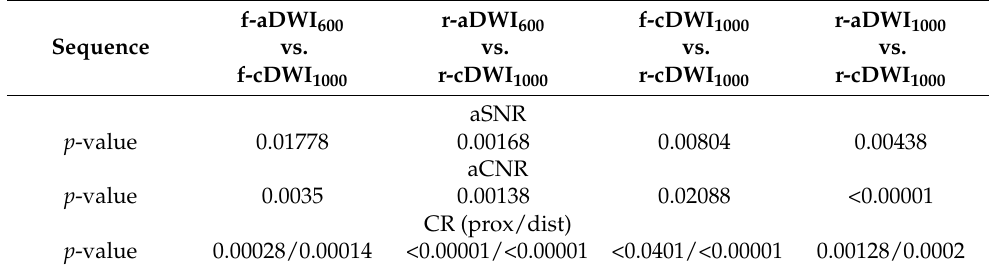
Table 4. p -values for comparison of quantitative image